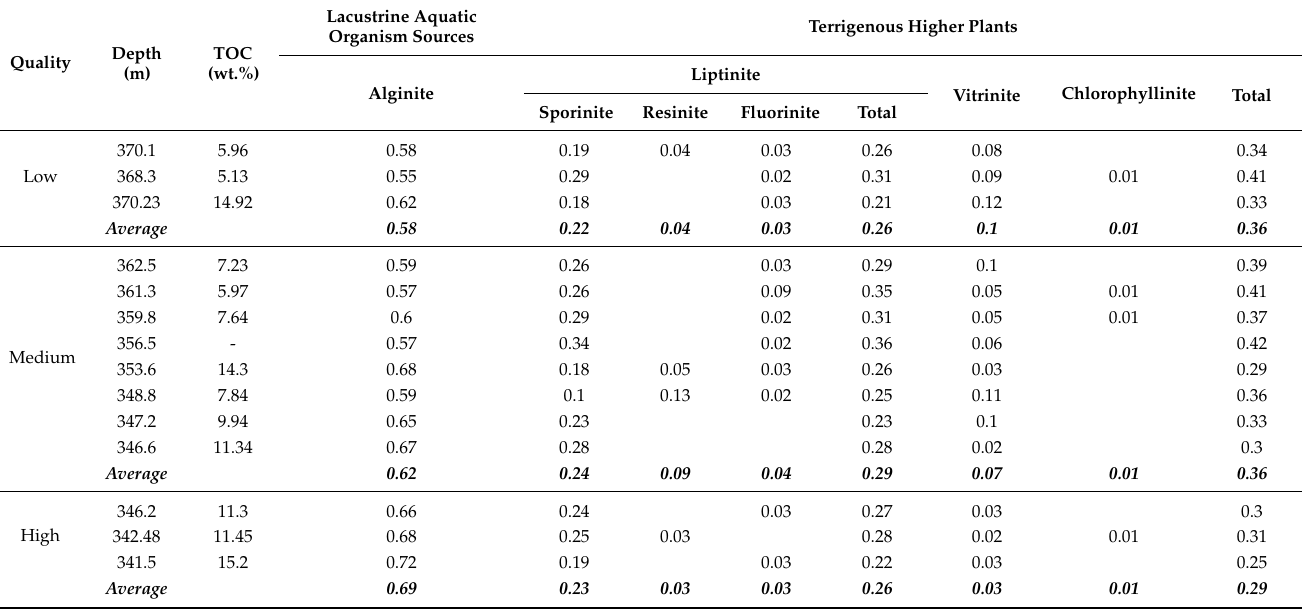
Table 5. Organic maceral composition of different-quality oil shales in the Shale Member of the Middle Jurassic Shimengou Formation, Yuqia area, Qaidam